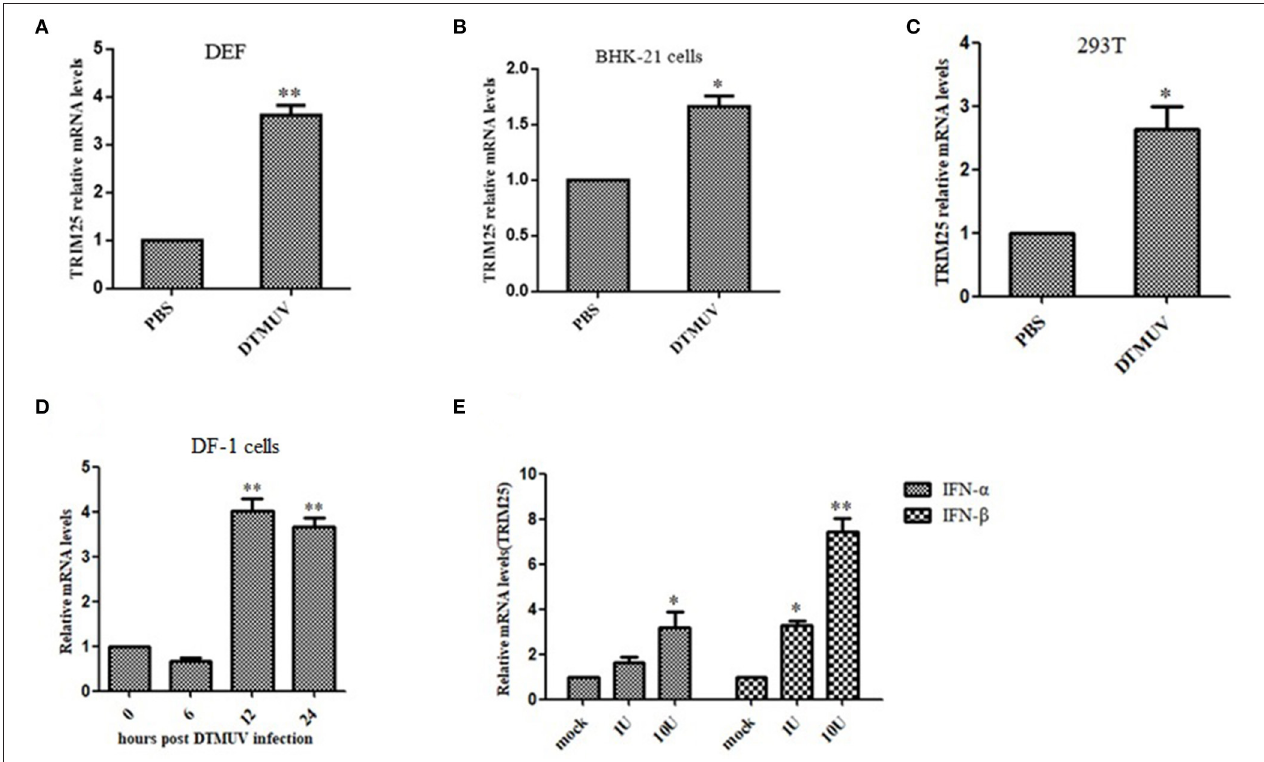
FIGURE 3 | TRIM25 is induced by duck Tembusu virus (DTMUV) infection or IFN stimulation. qRT-PCR analysis of TRIM25 mRNA expression in duck embryo fibroblasts (A) , BHK-21 cells (B) , 293T cells (C) ,and DF-1 cells (D) at 24h post-infection (hpi) with DTMUV at a multiplicity of infection (MOI) of one. Cells were harvested at 0, 6, 12, and 24 hpi. (E) qRT-PCR analysis of TRIM25 mRNA expression in BHK-21 cells upon stimulation with IFN- α or IFN- β . The expression levels were normalized to GAPDH or β -actin and expressed as fold-change. Data are means ± SEM of three independent